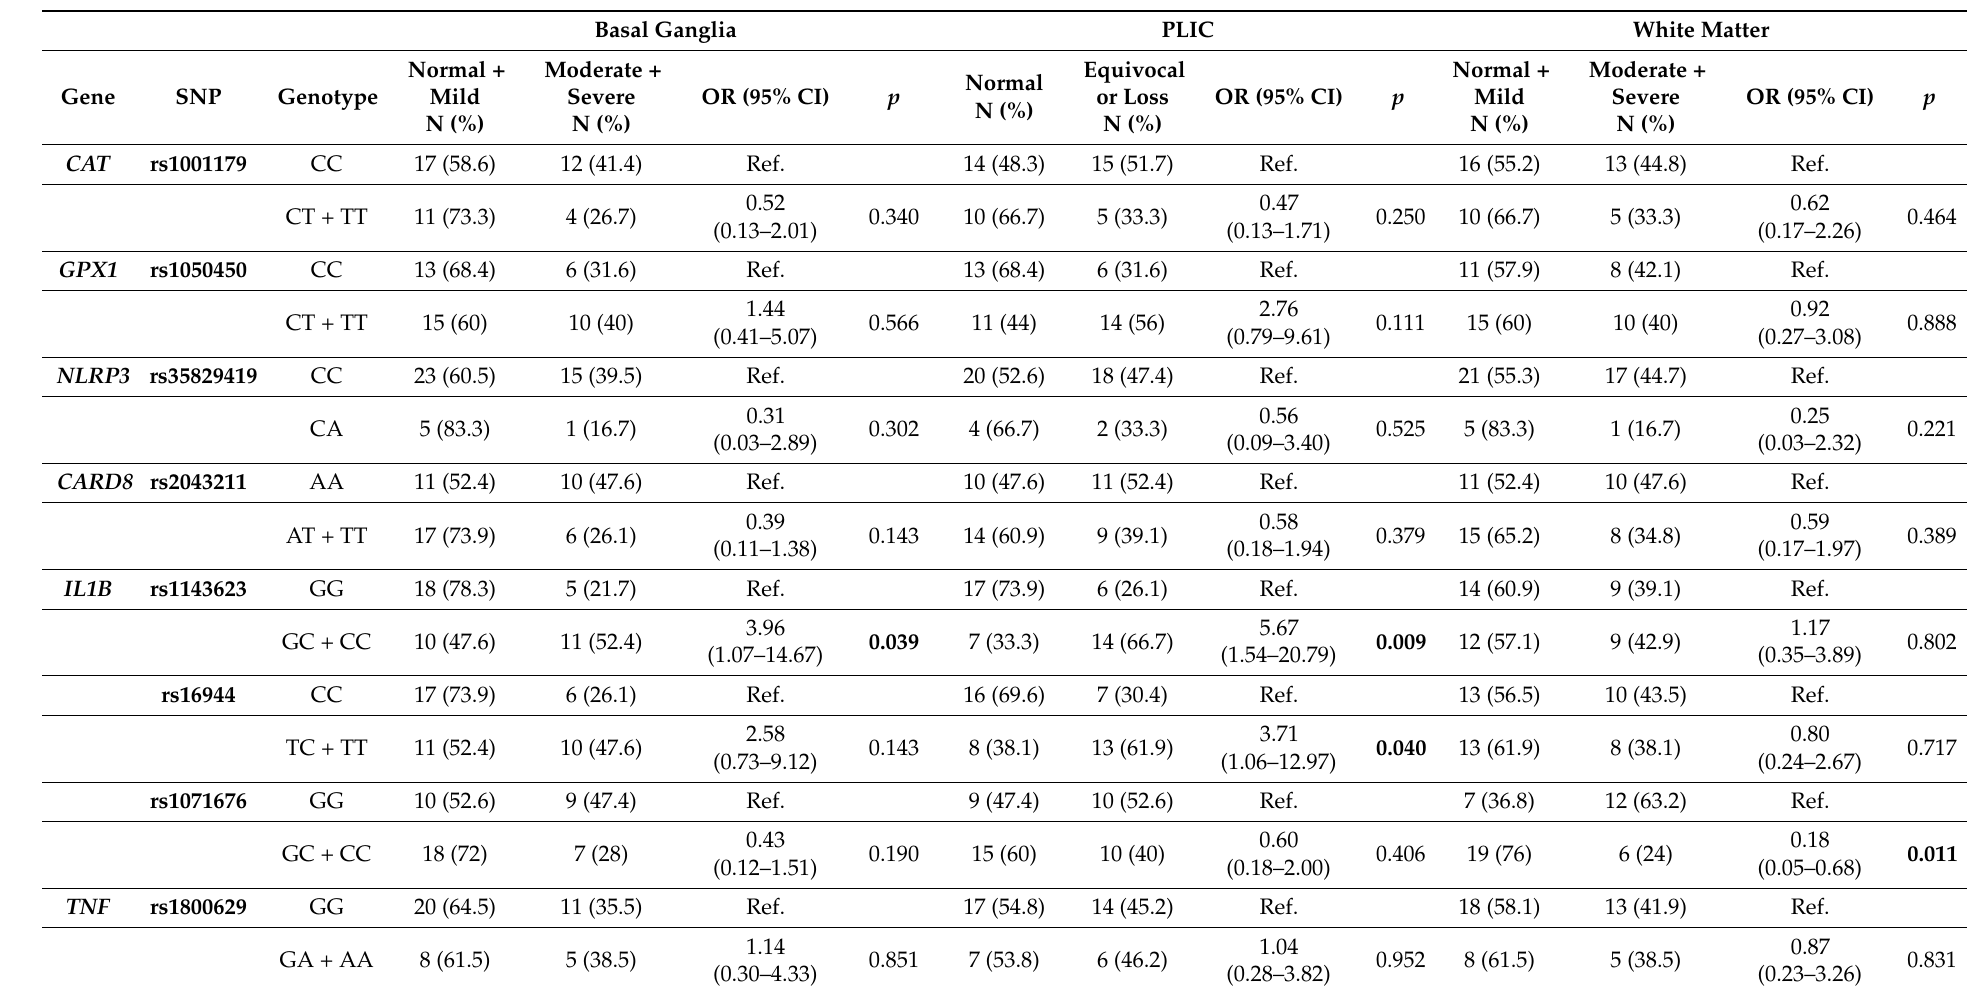
Legend: CI = confidence interval, OR = odds ratio, PLIC = posterior limb of internal capsule, SNP = single-nucleotide